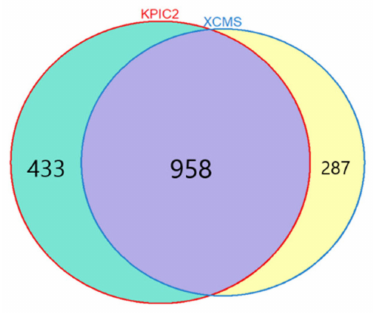
Figure 2. Venn diagram of the numbers of features in LCC dataset extracted by KPIC2 and XCMS. There are 433 features that are unique in KPIC2, and 287 features are also unique in XCMS. There are 958 common features detected by both KPIC2 and XCMS, which indicated the reliability of extrac- tion